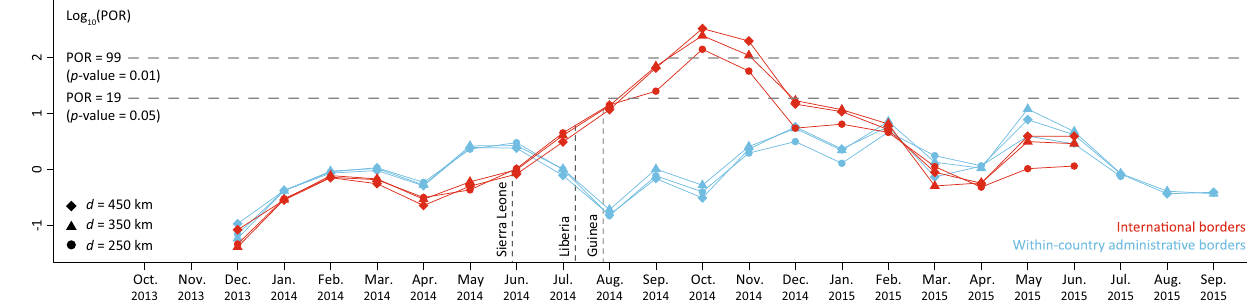
Fig. 4 Analysis of the monthly impact of inter- and intra-national borders on the EBOV dispersal frequency. The plot depicts the predictive odds ratio (POR) estimates per month and per data set ( d = 250, 350 and 450 km). POR estimates for within-country administrative borders are also included as a negative control as we do not expect any signi fi cant impact of within-country administrative borders on dispersal frequency. PORs >3 and >20 can be considered as ‘ positive ’ and ‘ strong ’ evidence for the impact of borders on the dispersal frequency, and PORs >19 and >99 correspond to posterior predictive p -values <0.05 and <0.01, respectively. Vertical-dashed lines indicate the time at which Sierra Leone, Liberia and Guinea announced their border closures. See Supplementary Fig. 4 for a more detailed representation of the monthly differences in crossing border events between inferred and simulated diffusion